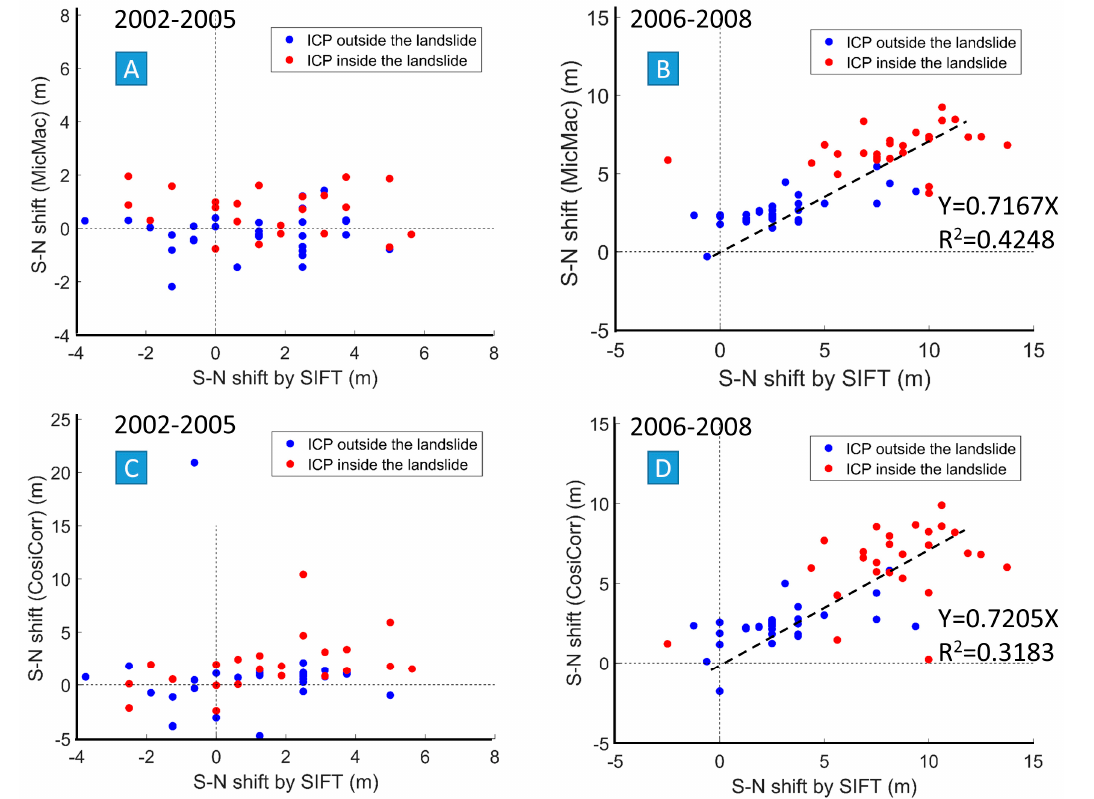
Figure 6. South-north (S-N) shifts measured on ICP by SIFT versus south-north shifts measured on the same points by Cosi-Corr ( A , B ) and MicMac ( C , D ) for the two periods (A,C for 2002–2005 and B,D for 2006–2008). No correlation is visible for the first period ( A , C ) between the shifts measured by SIFT and the shifts measured by MicMac and Cosi-Corr. For the 2006–2008 period, the shifts measured by both MicMac and Cosi-Corr are correlated to the shifts measured by SIFT on ICP. The red points are located on the landslide. The linear trend line equations relating the value of S-N shift measured by SIFT (X) to the S-N shift measured by Cosi-Corr or Mic-Mac (Y) and the associated coefficients of determination ( R 2 ) are given on ( B , D ). The coefficients of determination ( R 2 ) are low.